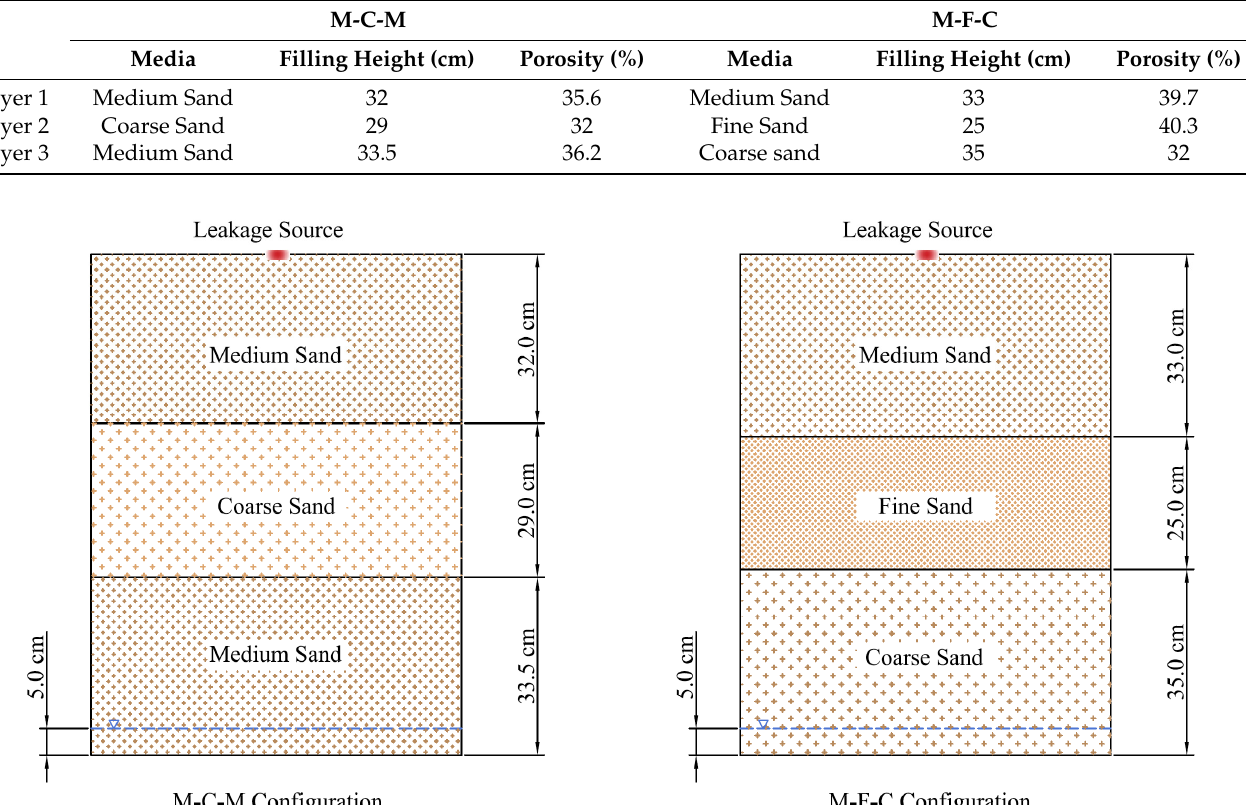
Table 2. Part of the physical properties of diesel